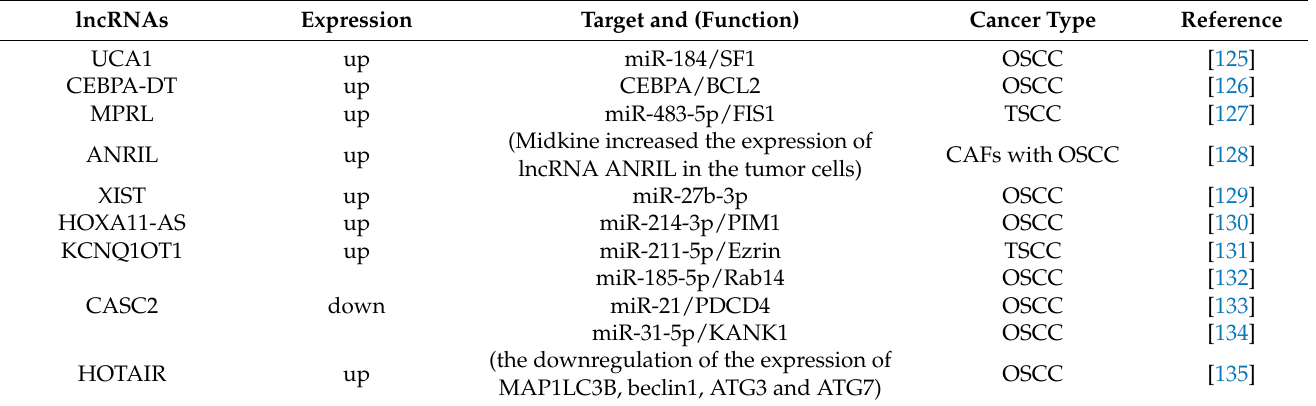
Table 2. lncRNAs associated with anti-apoptosis in